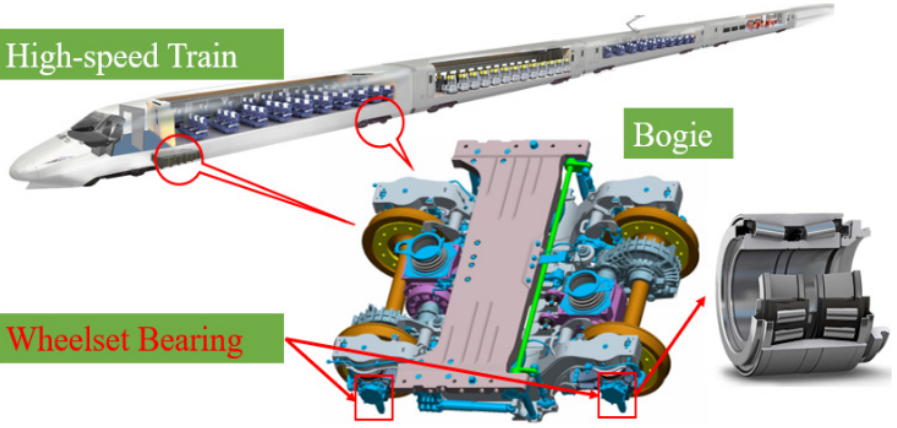
Figure 1. Schematic diagram of a high-speed train wheelset bearing structure.